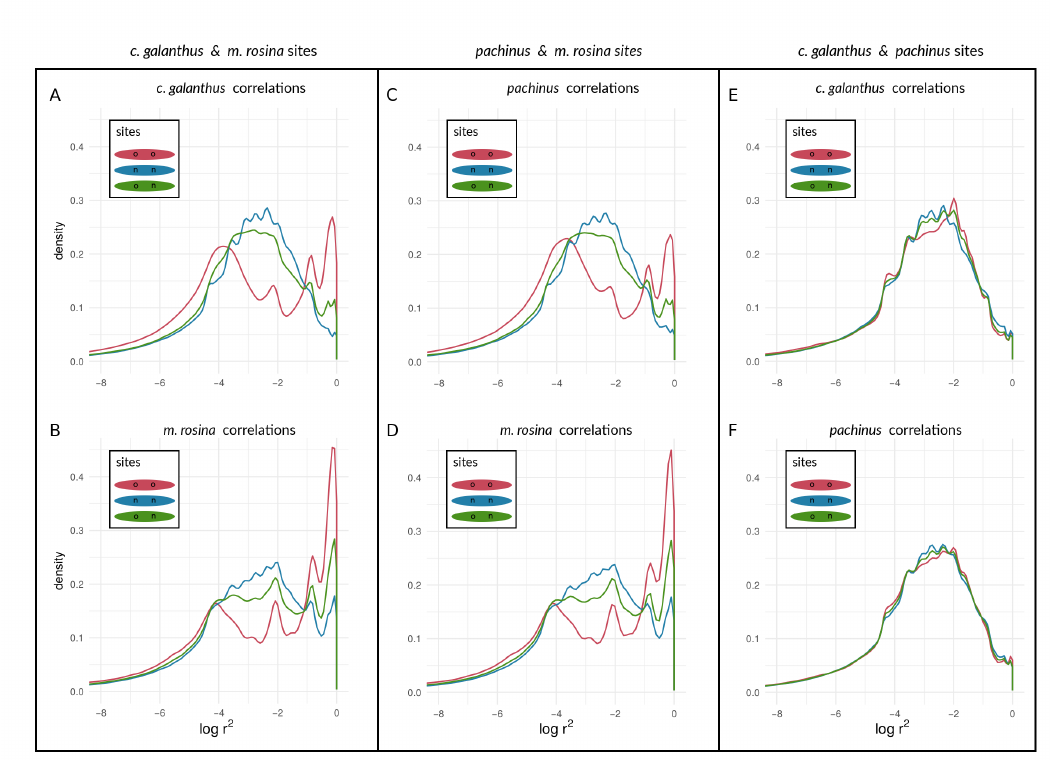
Figure 8. Density curves of within-species LD for loci at different types of sites on Chromosome 21, determined by F ST outliers. Log r 2 values are shown between outlier loci, between non-outliers, and between outliers and non-outliers for species pairs of H. cydno galanthus and H. melpomene rosina ( A , B ), of H. pachinus and H. melpomene rosina ( C , D ), and of H. cydno galanthus and H. pachinus ( E , F ).